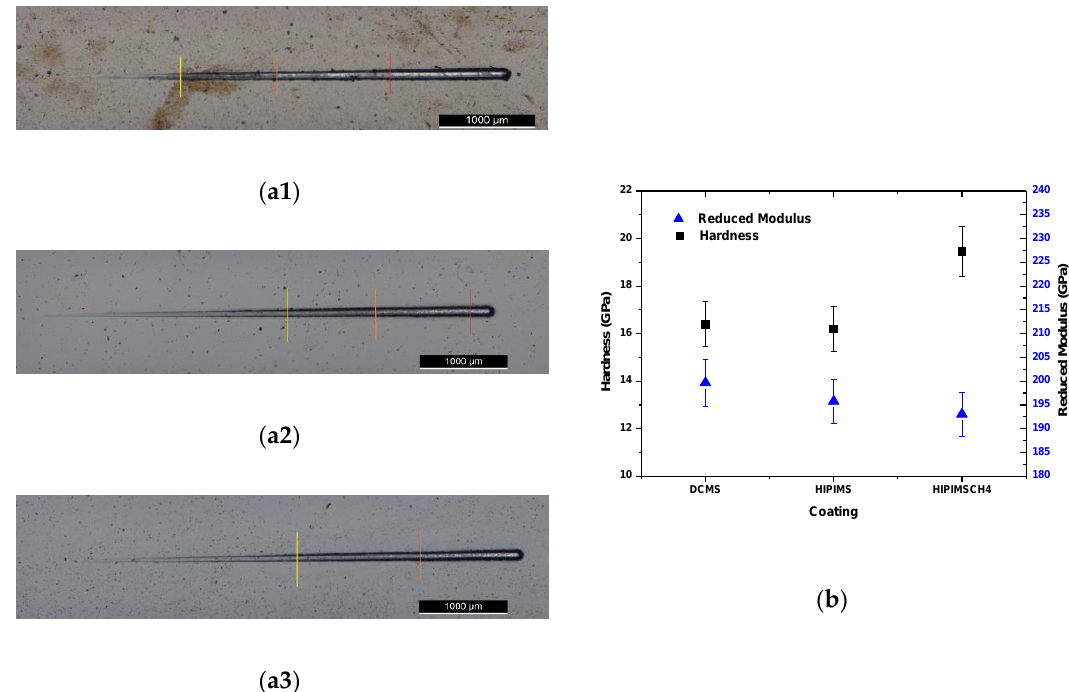
Figure 5. Adhesion scratches and critical loads of: ( a1 ) DCMS, ( a2 ) HIPMPS, ( a3 ) HIPIMS CH 4 ; Hardness and reduced Young´s modulus of the films ( b ).